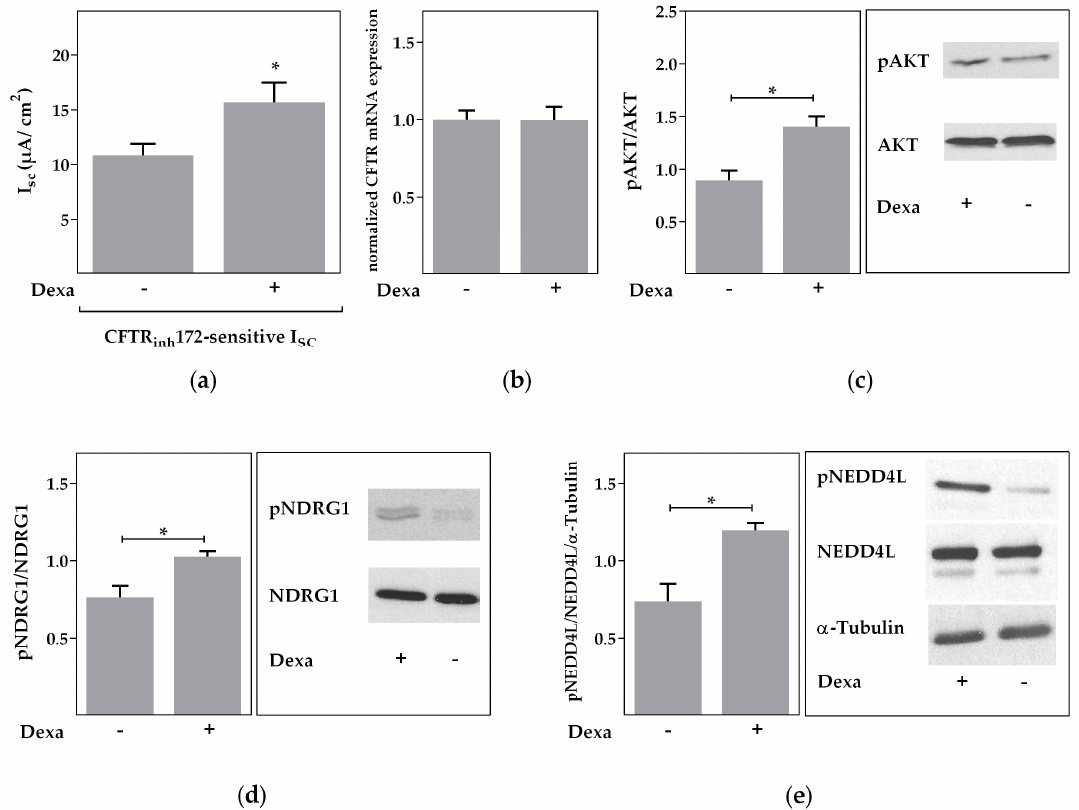
Figure 7. Rapid effects of dexa on CFTR activity. Calu-3 cells were treated with 100 nM dexa for 30 min. Data bars represent the mean + SEM. ( a ) The CFTR inh 172-sensitive I SC was significantly increased by dexa ( n = 60, * p < 0.05 by t-test with Welch’s correction); ( b ) CFTR mRNA expression was not affected by dexa ( n = 6); ( c ) normalized densitometric evaluation of pAKT and AKT Western blots ( n = 3; * p < 0.05 by t -test). Western blot of pAKT and total AKT resulted in bands of 60 kDa; ( d ) normalized densitometric evaluation of pNDRG1 and NDRG1 Western blots ( n = 3; * p < 0.05 by t -test). Western blot of pNDRG1 and total NDRG1 resulted in bands of 46 and 48 kDa; ( e ) normalized densitometric evaluation of pNEDD4L, NEDD4L and α -tubulin Western blots ( n = 3; * p < 0.05 by t -test). Western blot of pNEDD4L and total NEDD4L resulted in bands of 110 and 135 kDa. Western blot of α -tubulin resulted in bands of 52 kDa.